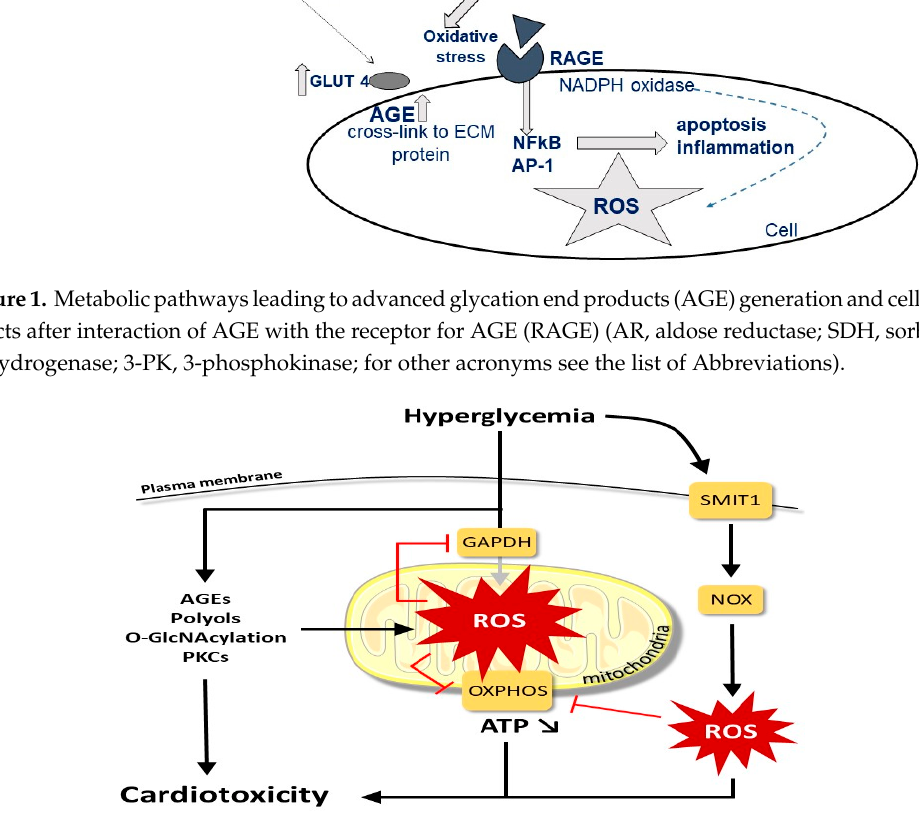
Figure 1. Metabolic pathways leading to advanced glycation end products (AGE) generation and cellular effects after interaction of AGE with the receptor for AGE (RAGE) (AR, aldose reductase; SDH, sorbitol dehydrogenase; 3-PK, 3-phosphokinase; for other acronyms see the list of Abbreviations).